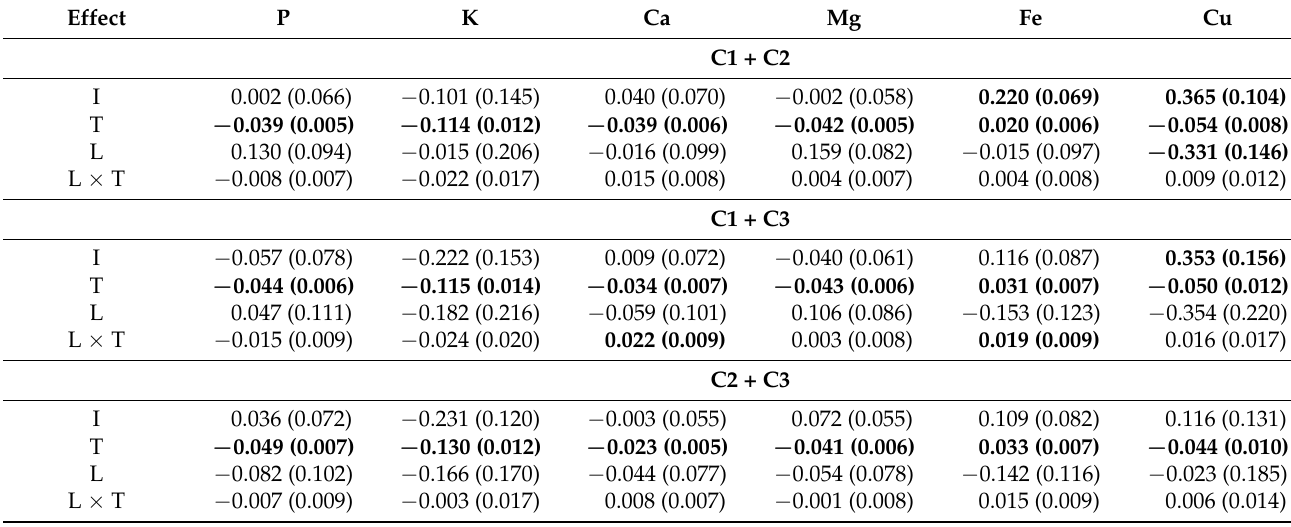
Table 5. Coefficients obtained from the adjustment of the generalized linear mixed models for the remaining nutrient content of P. taeda forest litter according to the comparison